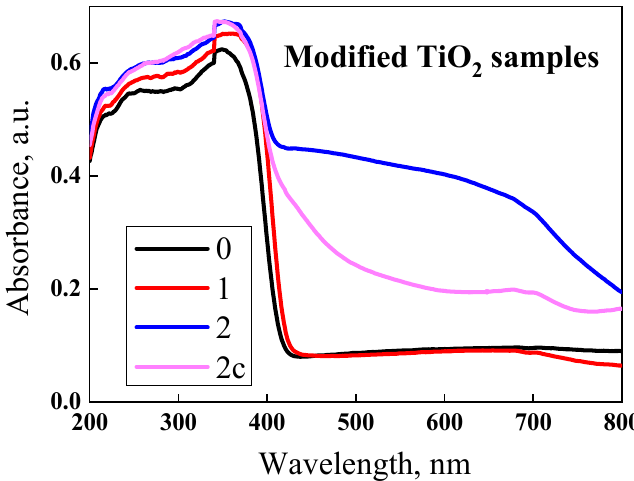
Figure 7. Comparative UV-VIS spectra for the samples: TiO 2 rutile (S0), TiO 2 decorated with 10% Ca 2+ (S1), and TiO 2 decorated with 10% Ca 2+ and 2% Cu 2+ uncalcined (S2) and calcined (S2c).